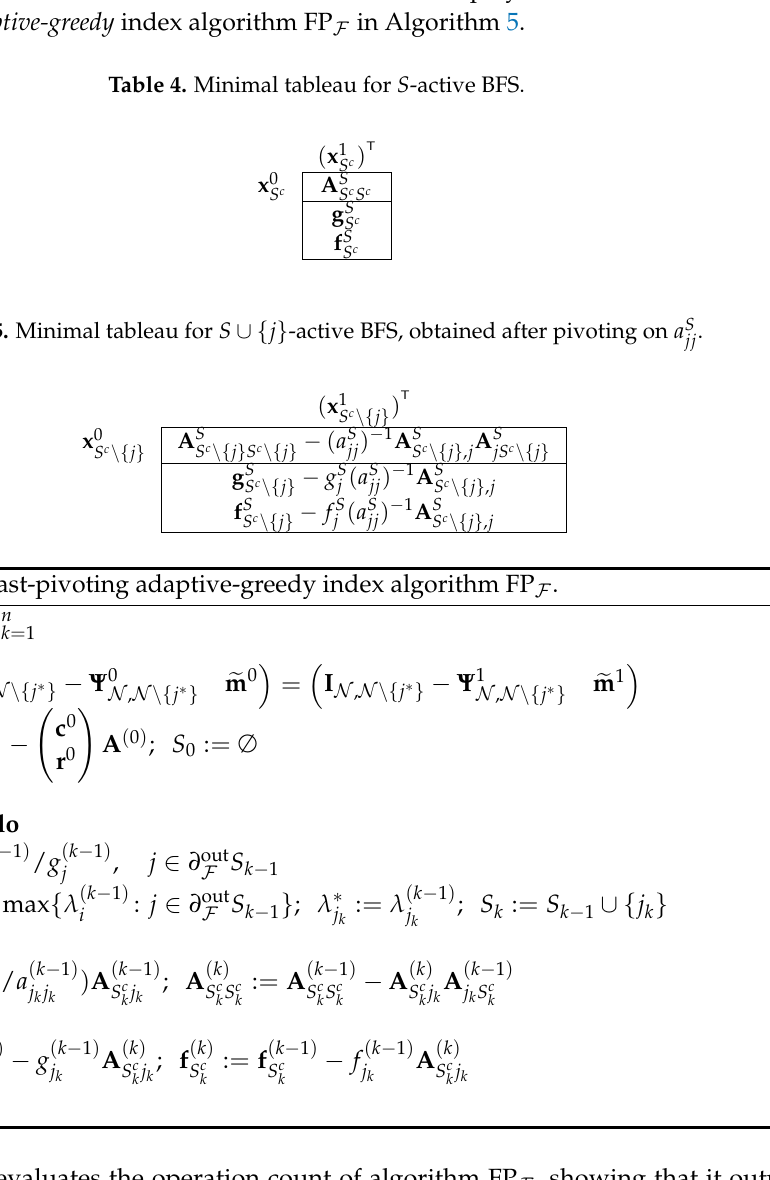
Table 4. Minimal tableau for S -active BFS.